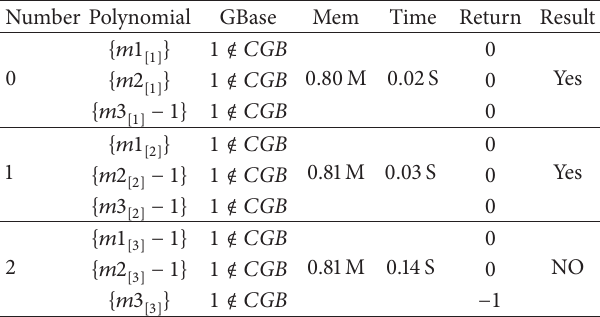
Table 6: Computation result